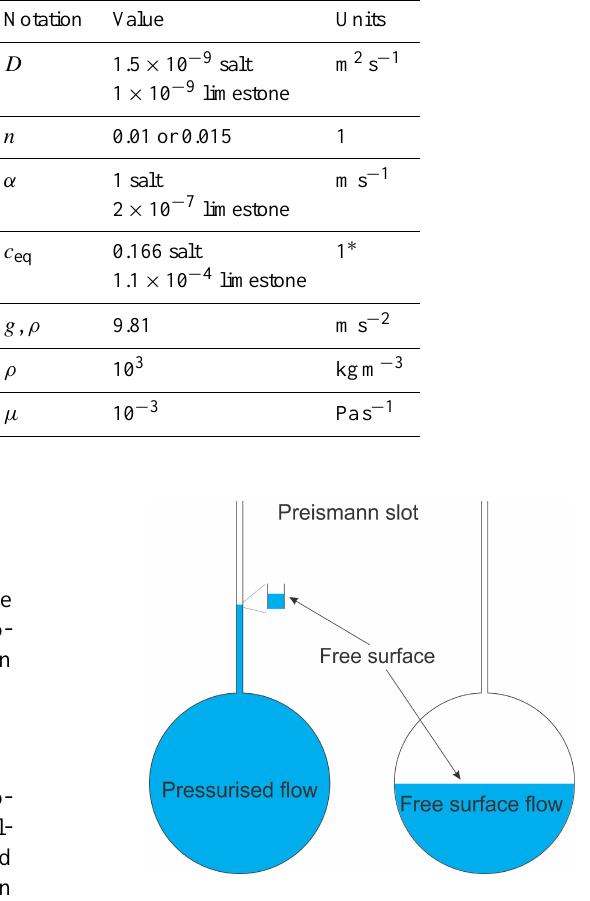
Figure 4. The use of a Preissmann slot enables use of the same set of equations for conduits with free-surface flow and conduits with pressurized